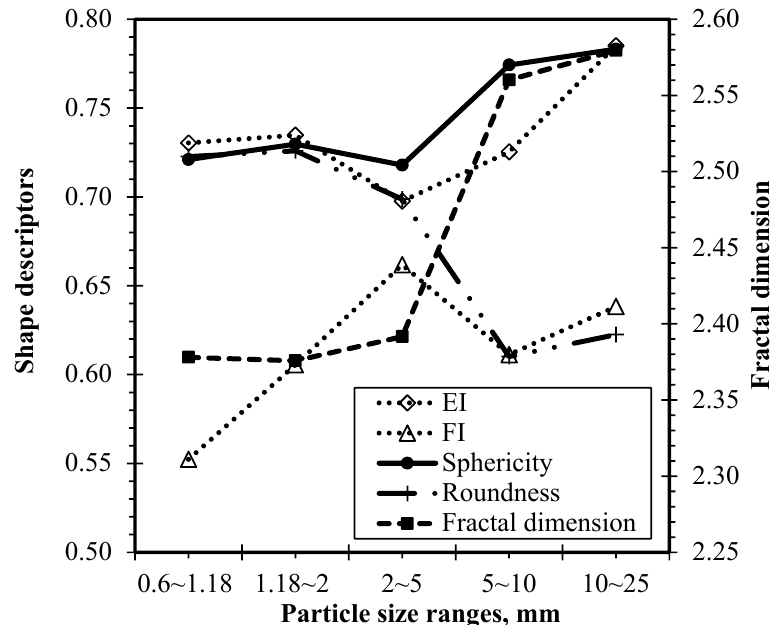
Figure 6. Variation of morphological descriptors with particle sizes. Table 1. Statistics of the 3D morphological descriptors at different particle sizes. Aspect Ratio Sphericity Roundness Fractal Dimension EL FL Particle Size, mm